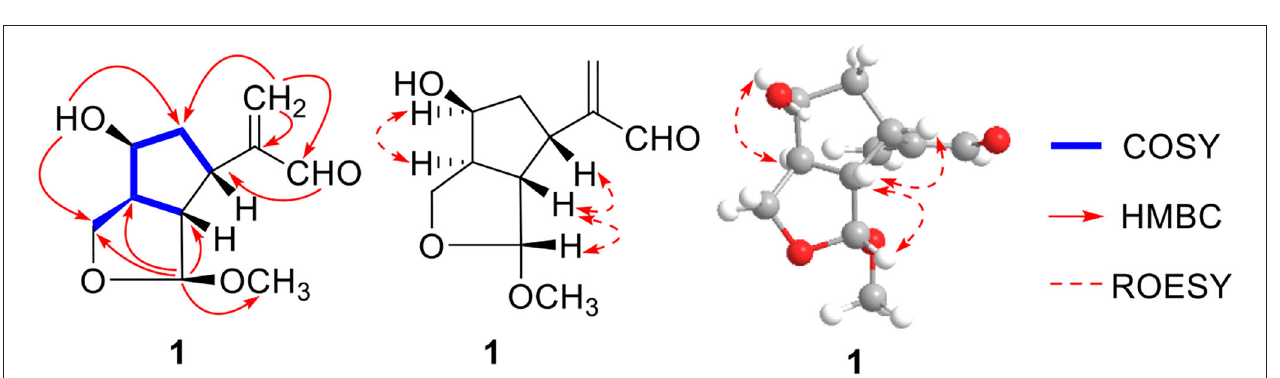
FIGURE 3 | Key 1 H- 1 H COSY, HMBC, and ROESY correlations of compound 1.